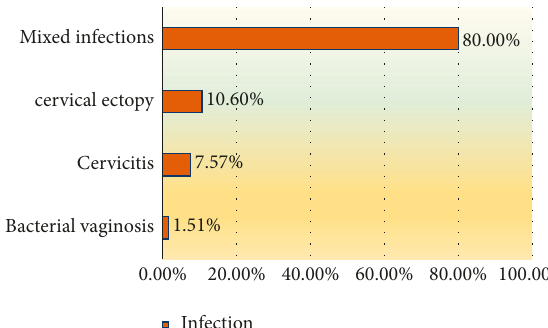
Figure 7: Prevalence of infection in participants with abnormal vaginal discharge. Table 2: Age, general temperament ( Mizaj ), and dystemperament of the uterus ( Su’-i-Mizaj al-Rahim ) in abnormal vaginal discharge. Age and general